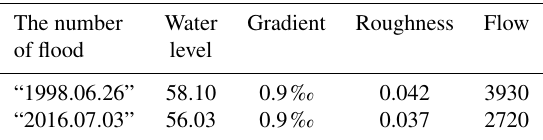
Table 1. Results of flood peak flow to investigation flood. The number Water Gradient